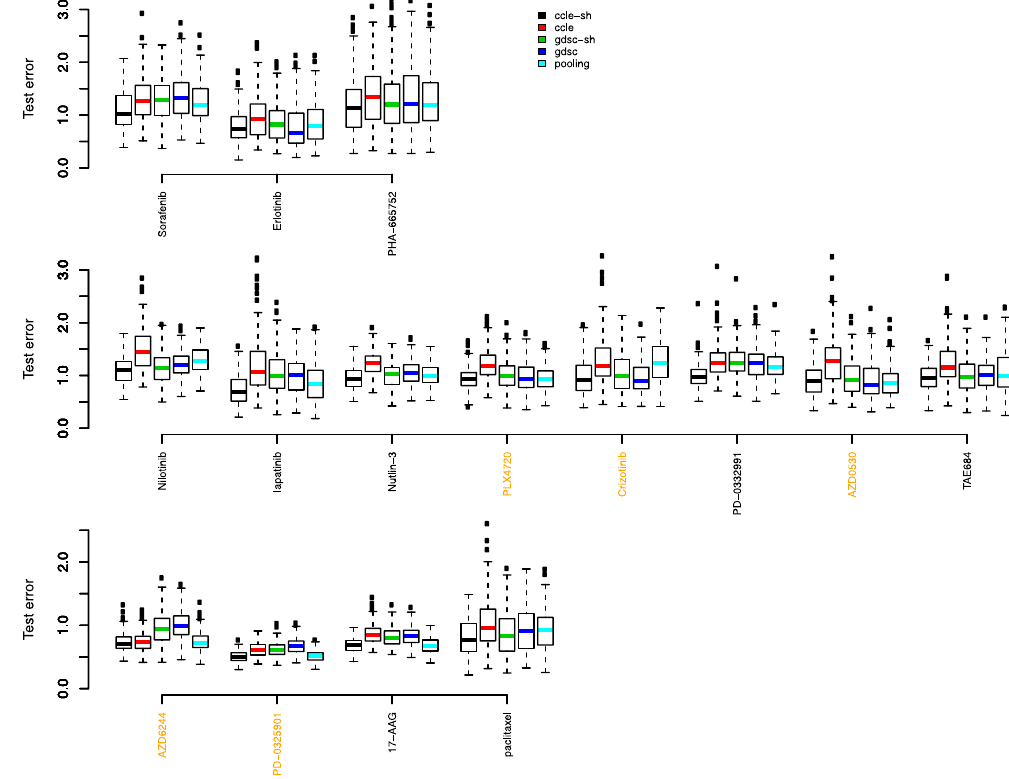
Figure 8. Test error rates by drug when 80% CCLE dataset were used in training data and 20% CCLE dataset were reserved as test data. Black represents predictions based on data sharing estimates for β alone; red for predictions from a model using GDSC alone; green for predictions from a data sharing model using estimates of β + δ ; blue for predictions from a model using CCLE alone, and light blue, predictions from a pooled GDSC + CCLE model.